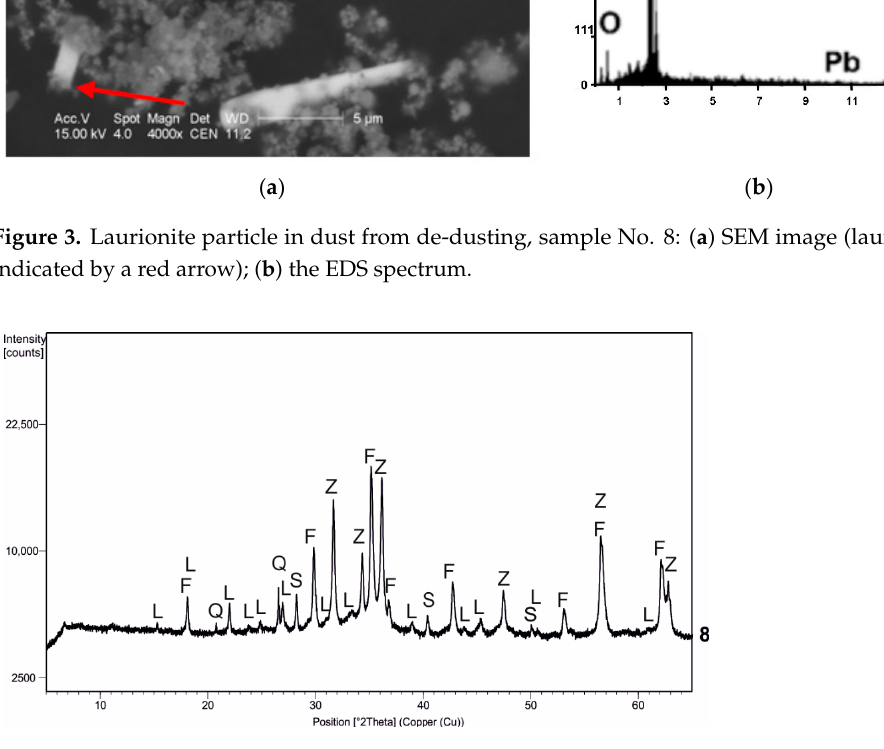
Figure 4. XRD pattern of de-dusting dust (sample No. 8). Symbol explanation: F—franklinite– jacobsite, L—laurionite, Q—quartz, S—sylvine, Z—zincite,